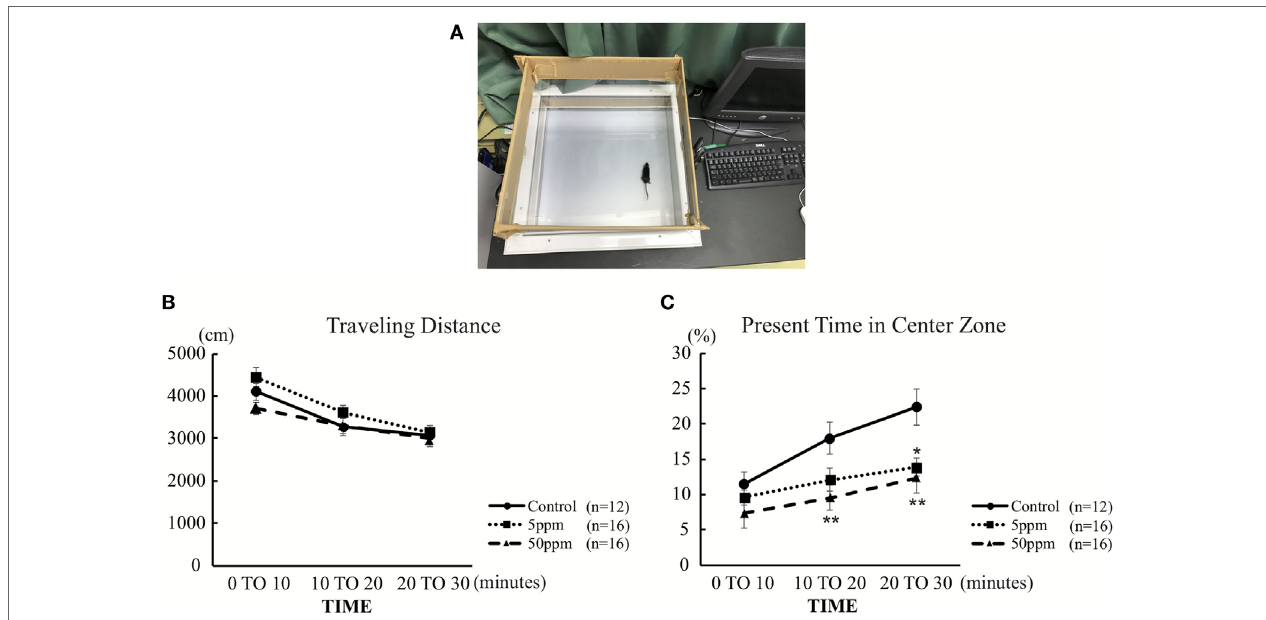
FigUre 3 | The effect of propylthiouracil treatment during in utero and postnatal periods in open field test. (a) Open field test apparatus. The open field was divided into two zones; peripheral area and central area. (B) Traveling distance in the open field. There was no difference in traveling distance among groups. (c) Time in the central area. The time was significantly altered at 20–30 min in the 5 ppm group and at 10–20 and 20–30 min in the 50 ppm group. Data are the mean ± SEM, * p < 0.05; ** p < 0.01 compared to the control group by Bonferroni